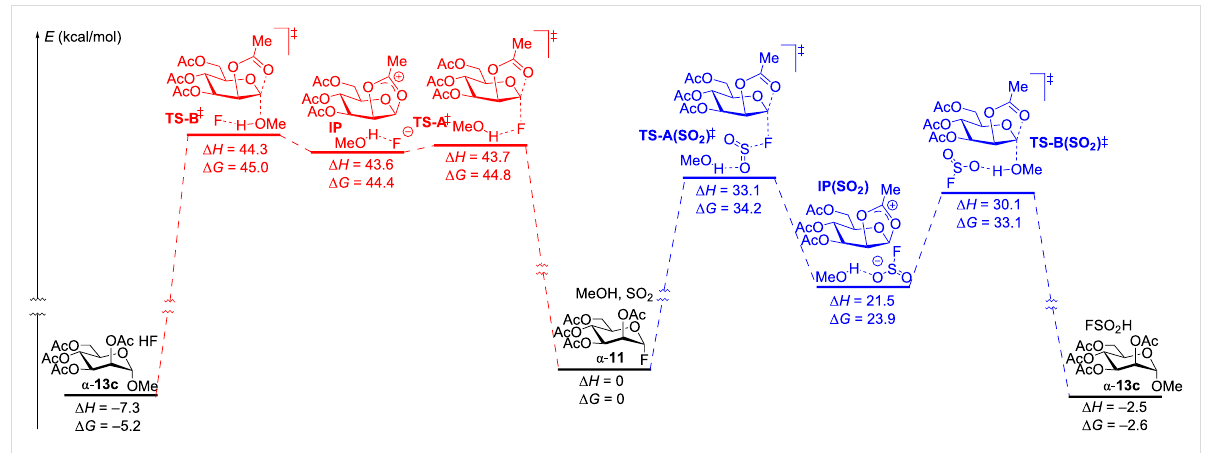
Figure 2: Computational study of reaction mechanism α - 11 + MeOH → α - 13c in the presence of and in absence of SO 2 (Gaussian 09, Revision D.01; Gaussian, Inc.; m052x method and the 6-31+g(d) basis set). Enthalpy and Gibbs free energy values referenced against the starting value for the substrates and catalyst are given in kcal/mol.